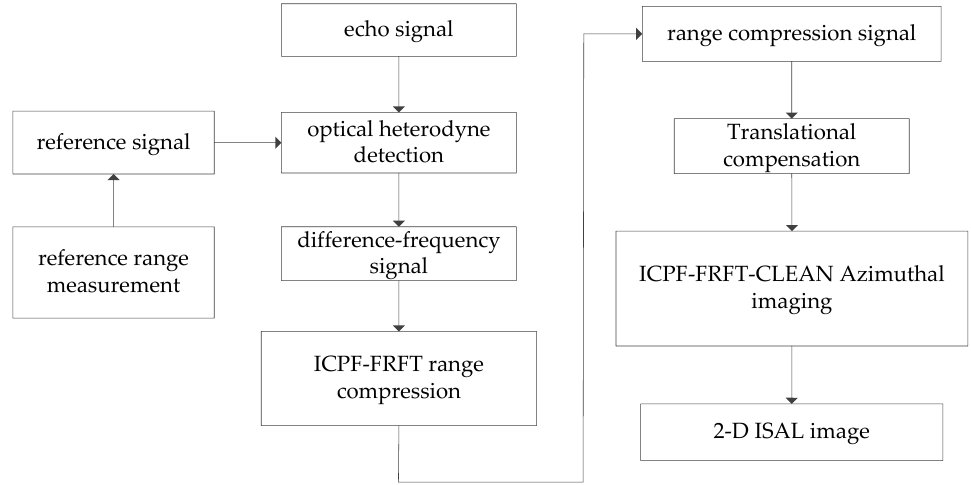
Figure 5. ISAL imaging algorithm flow for maneuvering target.